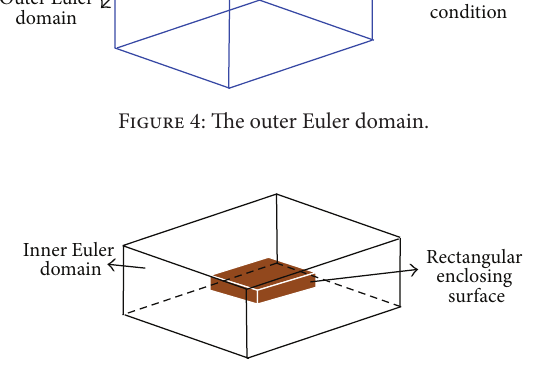
Figure 5: The inner Euler domain of